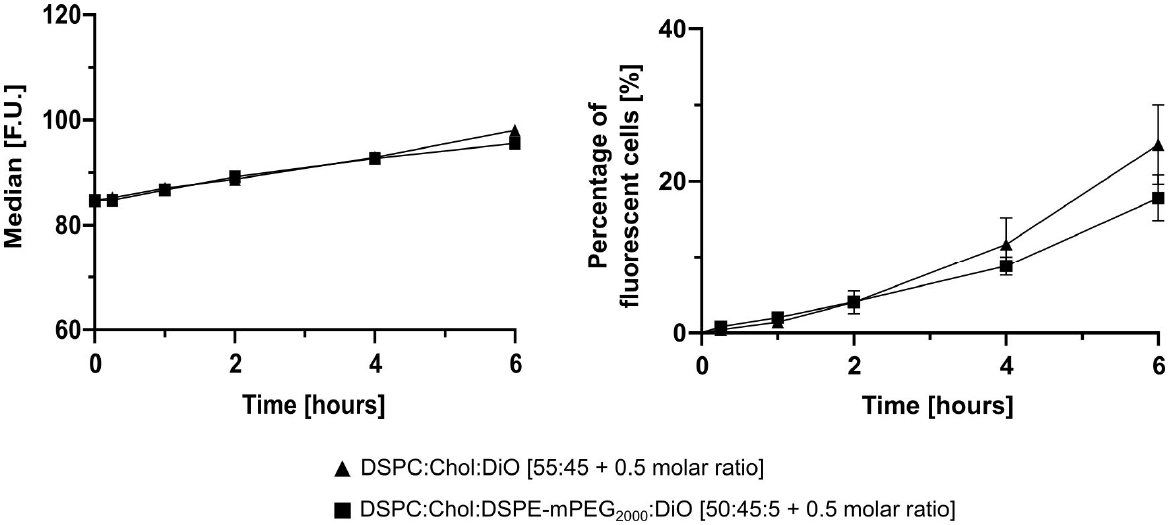
Figure 6. Cellular uptake of DiO labelled liposomes by 2D LS monocultures. 2D LS monolayers were incubated with non-PEGylated and PEGylated DiO labelled liposomes for 15 min, 1, 2, 4, and 6 h. Cellular uptake was evaluated via flow cytometry. The percentage of fluorescent cells (living gate) showed 24.8 ± 5.2% uptake for non-PEGylated and 17.8 ± 3.0% for PEGylated DiO liposomes. Data are expressed as the mean ± SD ( n = 3).